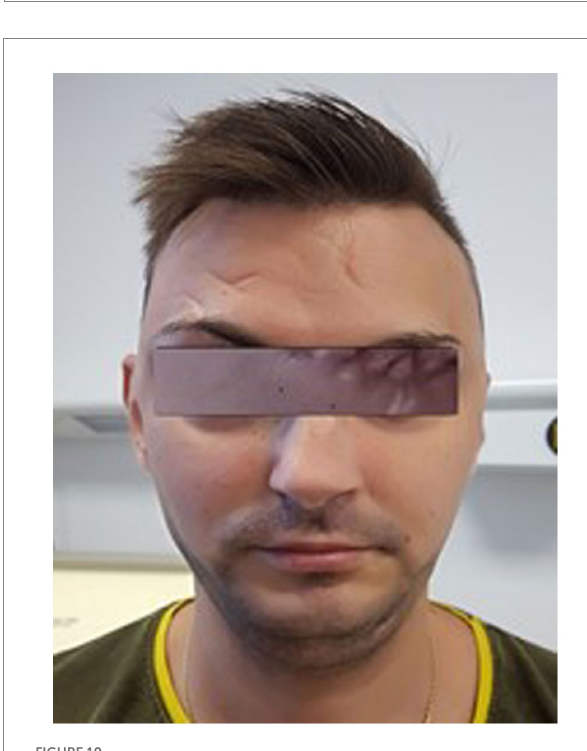
FIGURE 10 Front view of the patient, 1 month after the angiographic intervention.